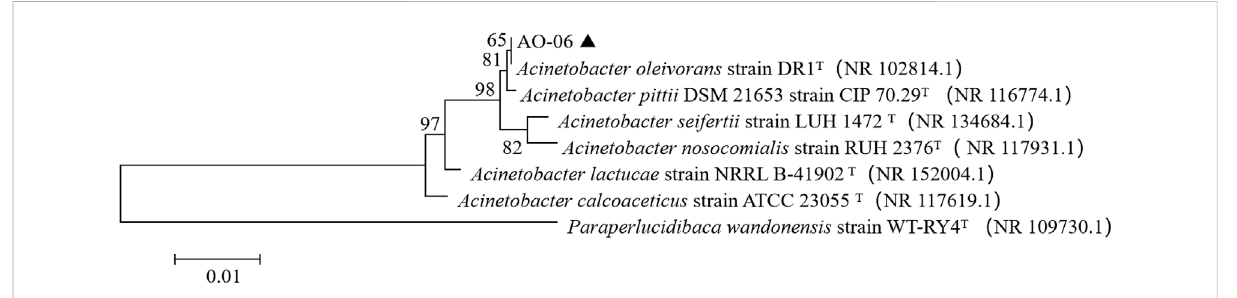
FIGURE 2 A 16S rRNA phylogenetic tree containing strain AO-06.